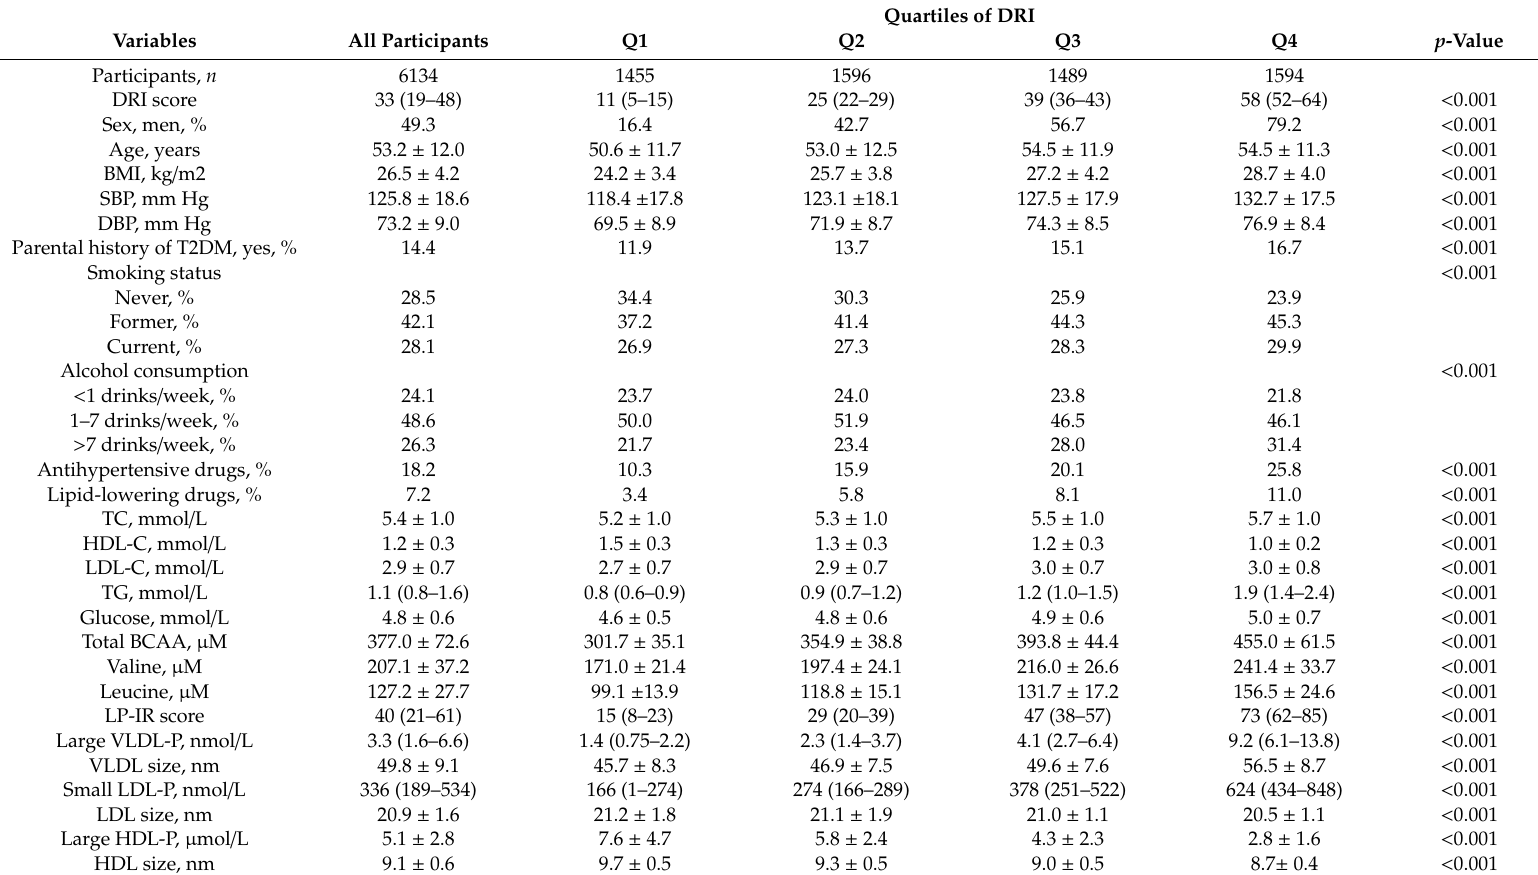
Table 1. Baseline characteristics by quartile of DRI scores in PREVEND participants free of T2D at baseline ( n =